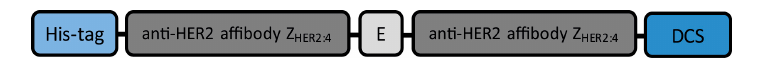
Figure 1. The (Z HER2:4 ) 2 DCS diaffibody construct is composed of two Z HER2:4 units separated by a single glutamate residue (E), a 6× His-tag at the N-terminus, and a drug conjugation sequence (DCS) at the C-terminus.